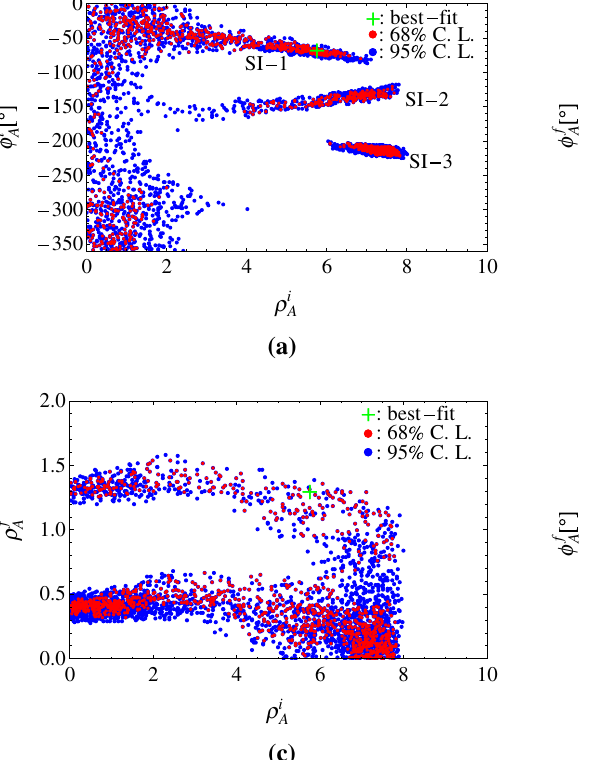
,φ f ) planes ( c , d ) in order to show the possible correlation. and (φ i A A The best-fit point corresponds to χ 2 ,ρ f ) A A